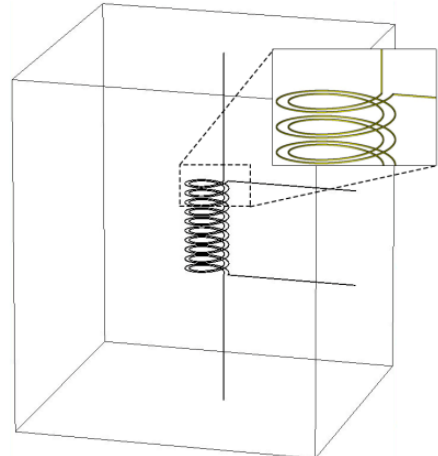
Figure 7. Finite element method (FEM) model of the filaments.